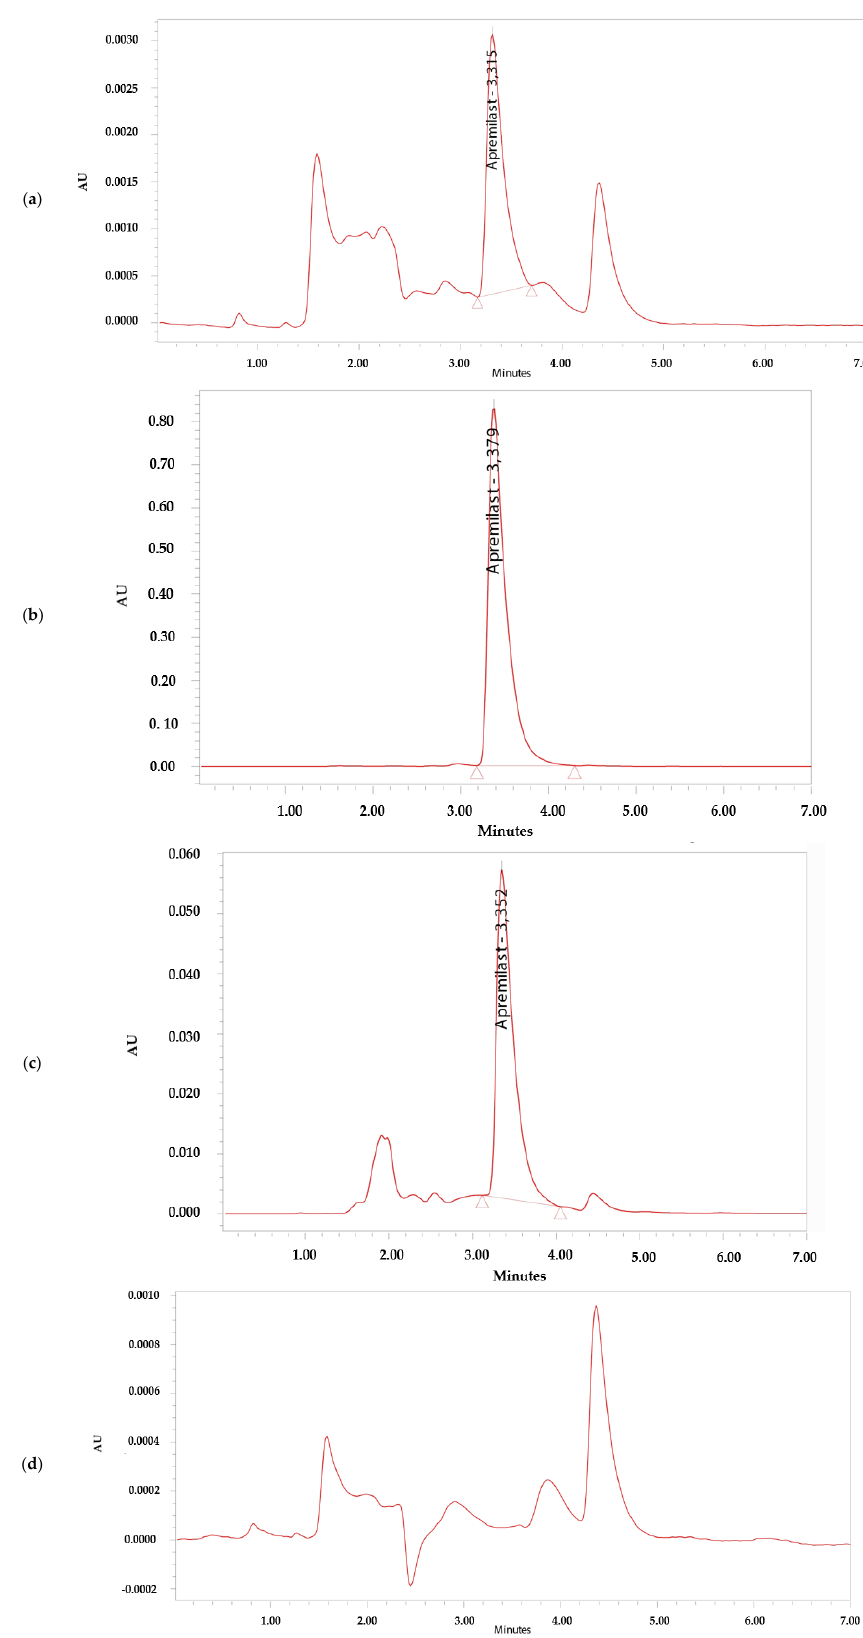
Figure 2. Chromatograms. ( a ) Apremilast standard 0.156 µ g/mL. ( b ) Apremilast standard 100 µ g/mL. ( c ) Apremilast extracted from human skin after the permeation study. ( d ) Blank